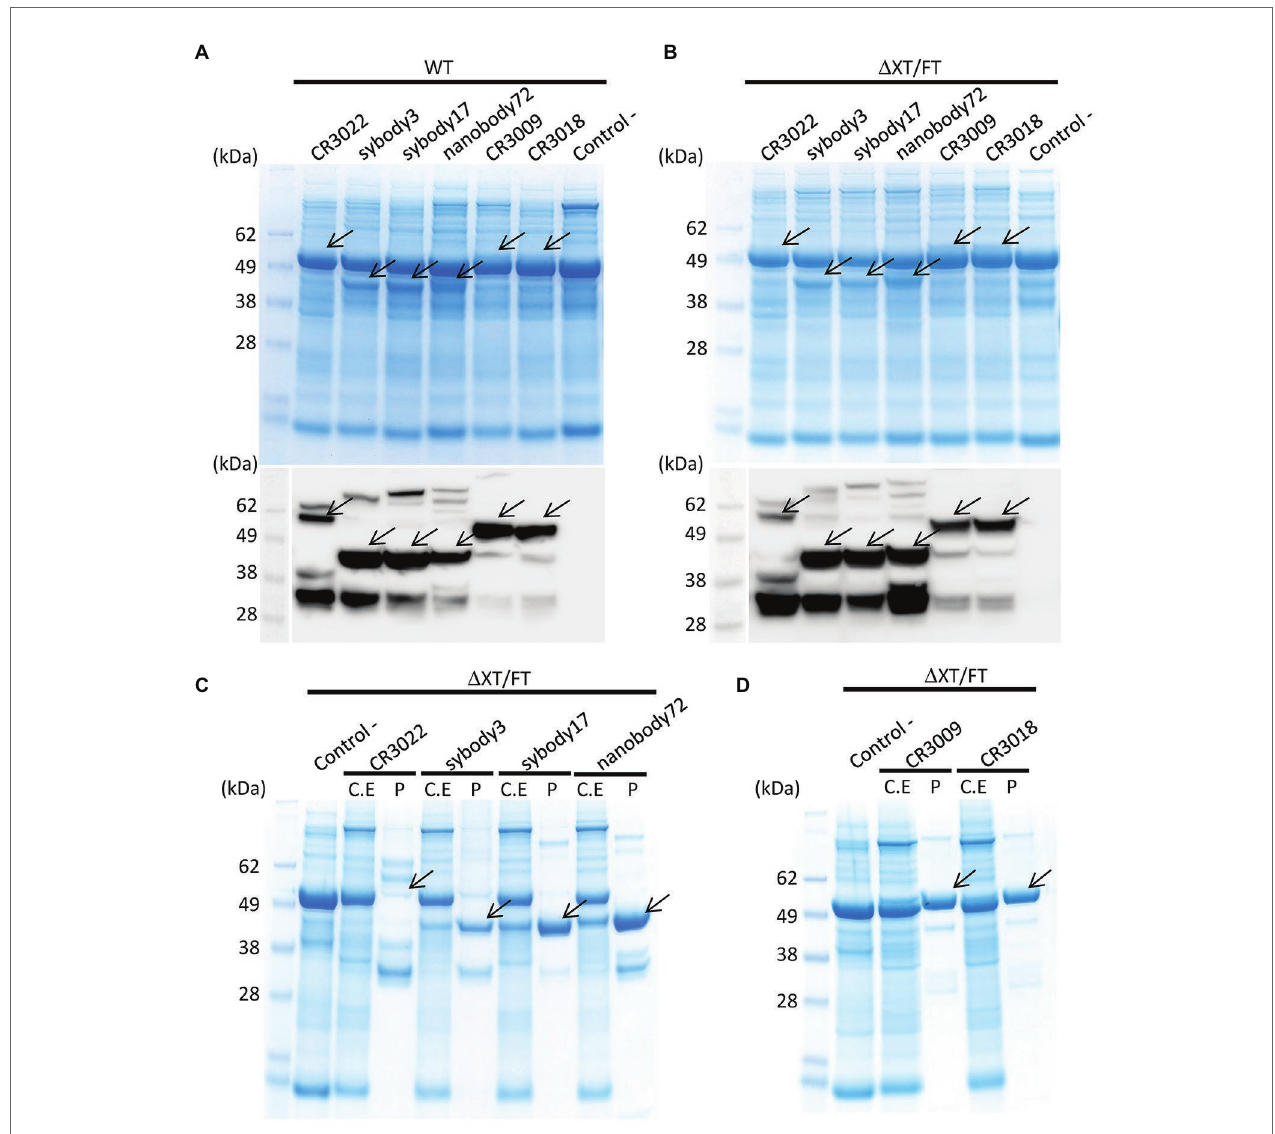
FIGURE 2 | Analysis of the expression of all six anti-SARS-CoV-2 recombinant antibodies produced in N. benthamiana leaves. Coomassie stained SDS gels (upper panel) and Western blots (down panel) of protein extracts from wild-type (A) and Δ XT/FT (B) N. benthamiana leaves agrotransformed all of them with six antibodies. Seventeen microliter of crude extract was loaded per well in SDS gels. The blots were incubated with an antibody against constant region of human IgG. (C,D) Coomassie stained SDS gels with purified (P) recombinant antibodies from Δ XT/FT plants compared to their corresponding protein crude extract (C.E) for each analyzed antibody. Twenty microgram of total protein from crude extract per well and 3 μ g of purified protein per well were loaded in SDS gels. Control samples ( − ) were agroinfiltrated with Integrase module and pICH11599_DsRed vectors only, as indicated in section Materials and Methods. Arrows indicate the presence and position of the corresponding band protein for each